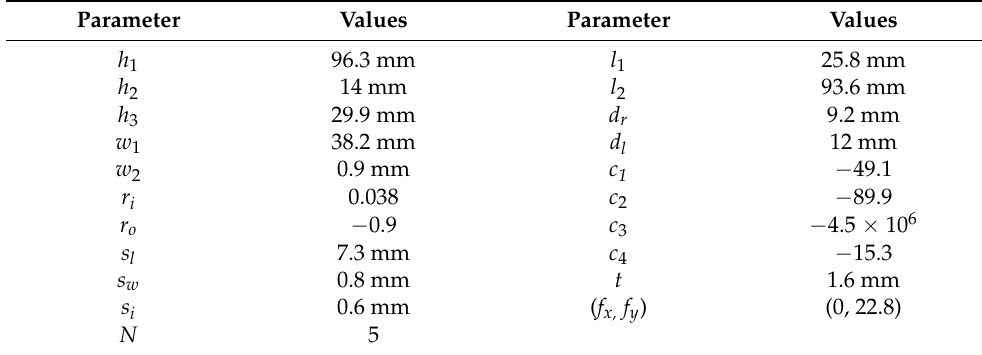
Table 2. Values of the optimized array antenna